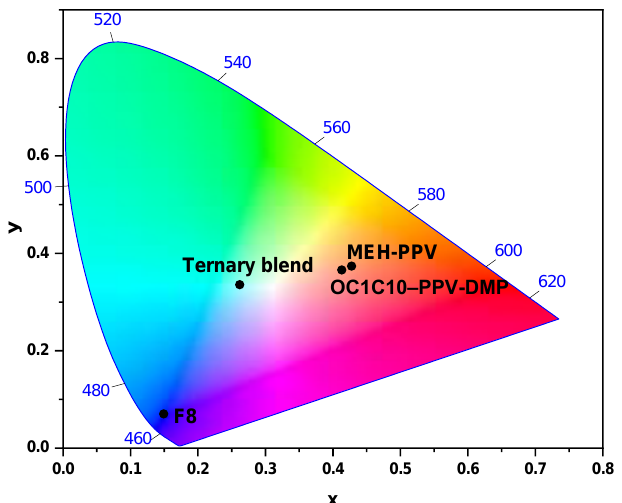
Figure 5. CIE coordinates for pristine F8, MEH-PPV, OC1C10–PPV-DMP, and their ternary hybrid.